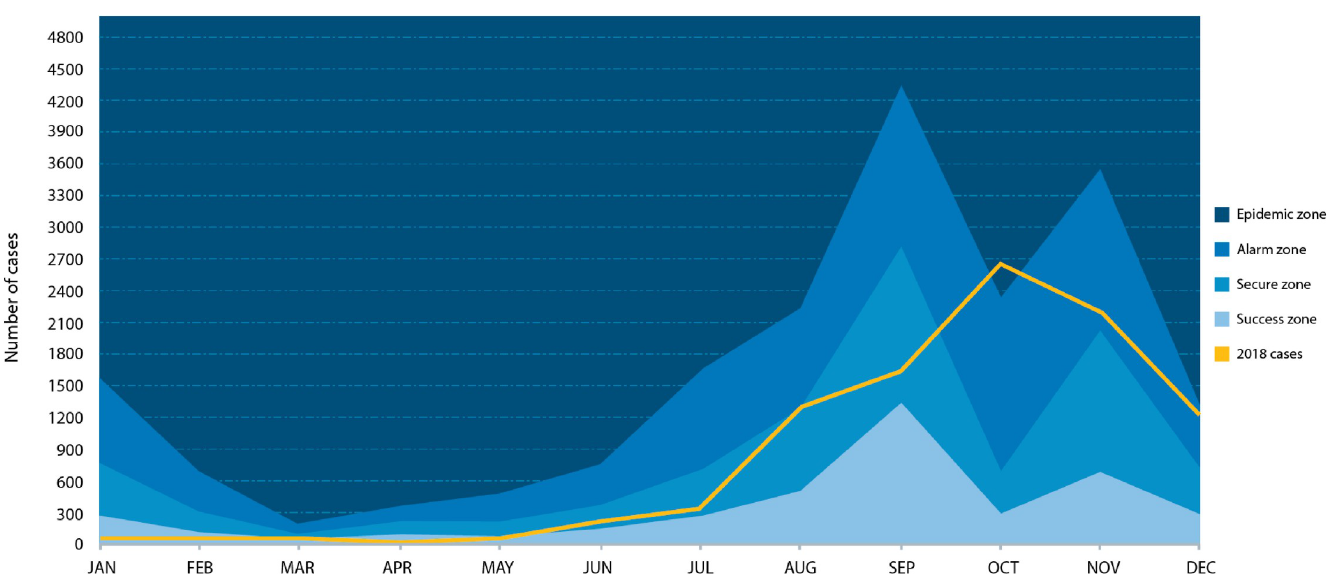
Fig 5. Dengue endemic channel updated for 2018. The endemic channel was built with the estimated incidences of 2015–2017, over which the estimated monthly cases for the year 2018 were plotted.